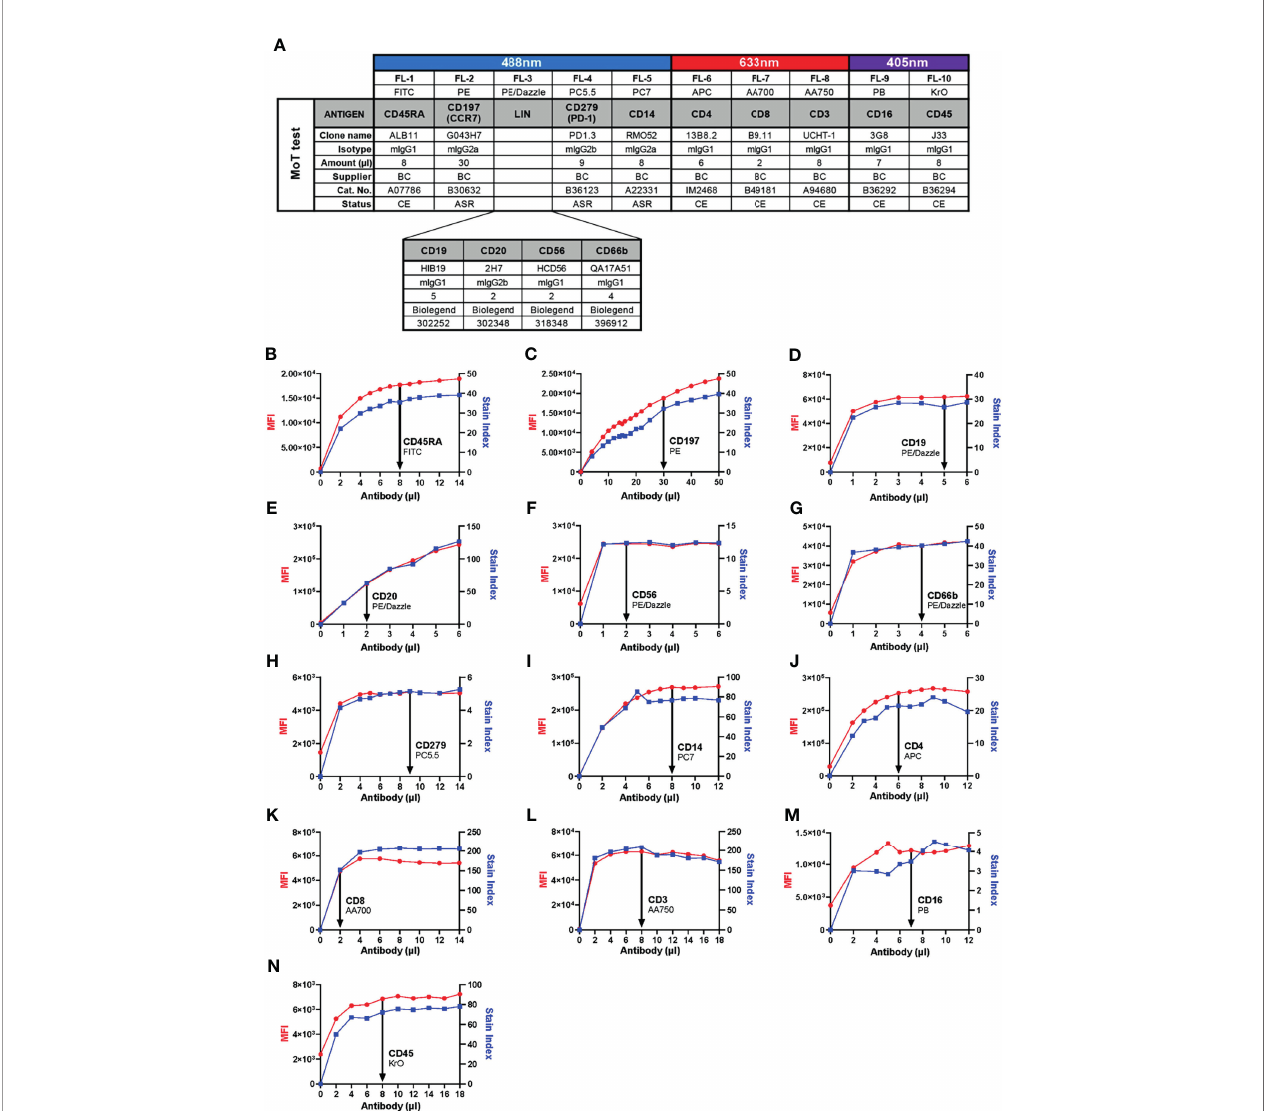
FIGURE 1 | Development of the 10-color “ MoT test ” to concurrently analyze CD3 + T cells, CD4 + T EM cells, CD279 + CD8 + T cells and CD14 + monocytes. (A) Antibodies against CD45, CD3, CD4 and CD8 were used as T cell backbone. Lineage antibodies against CD19, CD20, CD56 and CD66b were used for exclusion of B cells, NK cells and granulocytes. Antibodies against CD45RA and CCR7 were used for the characterization of memory T cell subsets. a CD279 was used to characterize late-activated and exhausted T cells. a CD14 and a CD16 were used for subsetting monocytes. (B – N) Titration of antibodies included in the MoT test. Optimal concentrations were chosen according to MFI and Stain